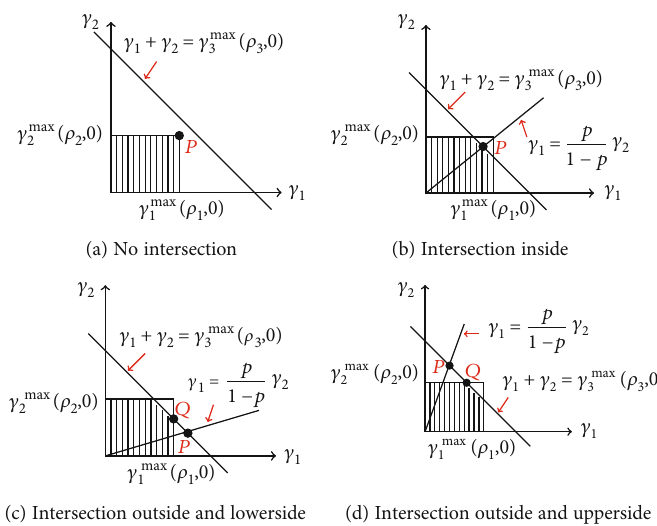
Figure 3: Cases that illustrates feasible set for solution of the Riemann solver at